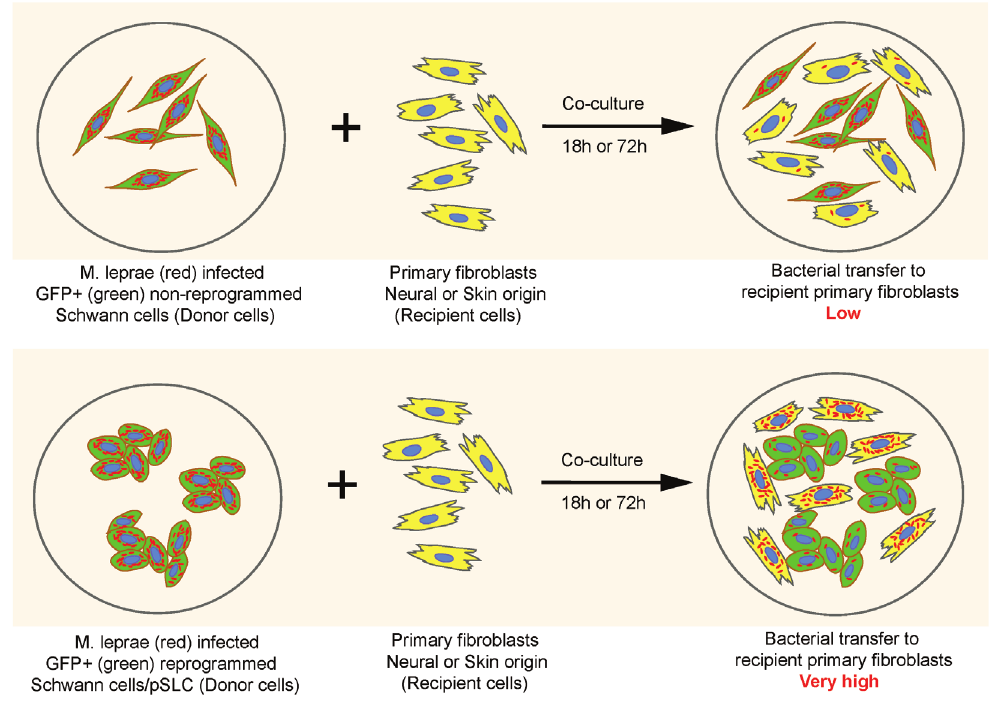
Figure 1. Schematic illustrating the summary of the experimental approach and the results. GFP+ non-reprogrammed and reprogrammed Schwann cells (pSLC) that are infected with ML (red bacteria in green cells) are co-cultured with exogenously added primary fibroblasts (yellow) derived from adult peripheral nerves or skin. Evaluation of bacterial transfer to recipient fibroblasts from GFP+ cells after 18h and 72h revealed an effective bacterial retention in non-reprogrammed cells (top) and a significant ML transfer to fibroblasts from reprogrammed Schwann cells